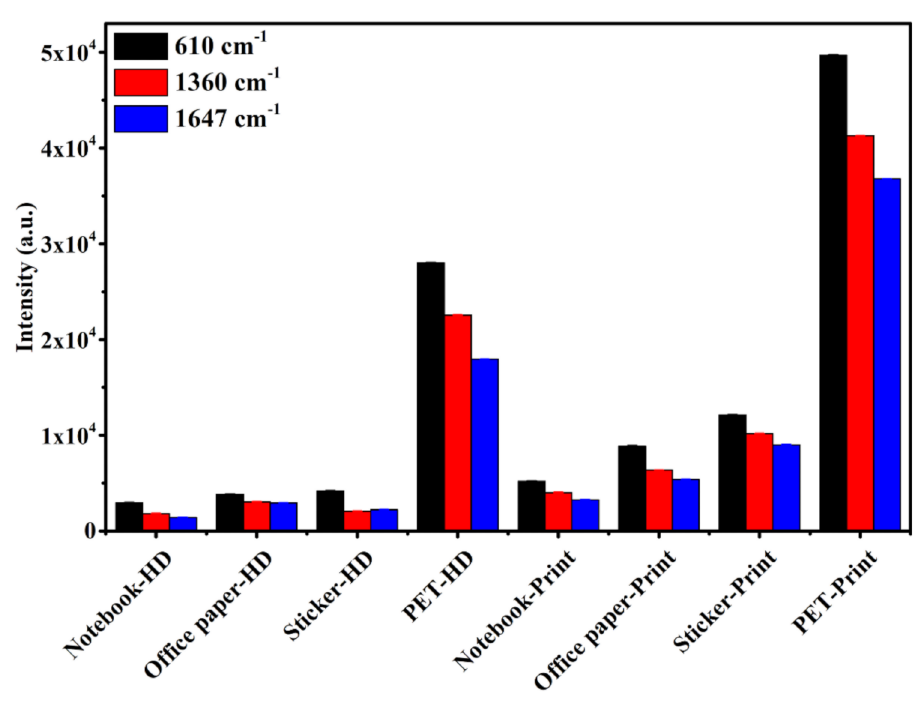
Figure 4. SERS Performance of SERS Substrates prepared using different support matrices and fabrication methods. (Raman signals intensities of R6G at 610 cm − 1 , 1360 cm − 1 , and 1647 cm − 1 versus different support matrix and fabrication methods. HD presents hand